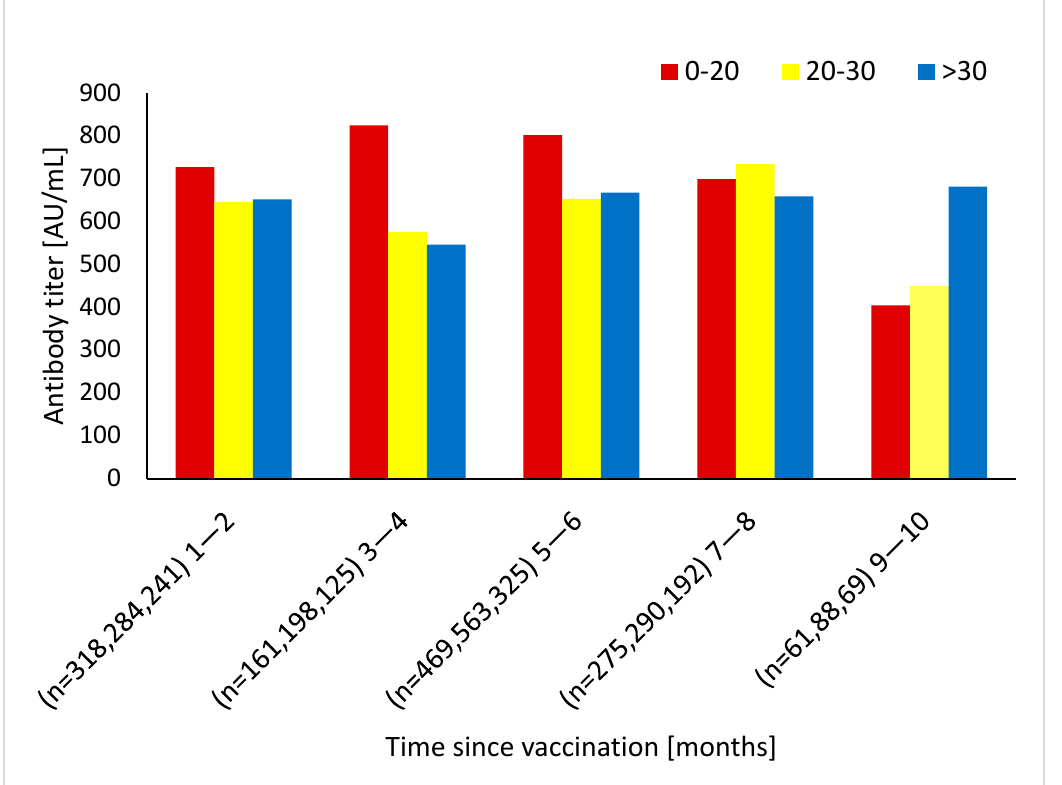
Figure 4. Antibody titers from vaccinated groups stratified by baseline 25(OH)D levels at each time point since 2nd vaccination. The Kruskal–Wallis tests with multiple comparisons was used to compare between the groups.